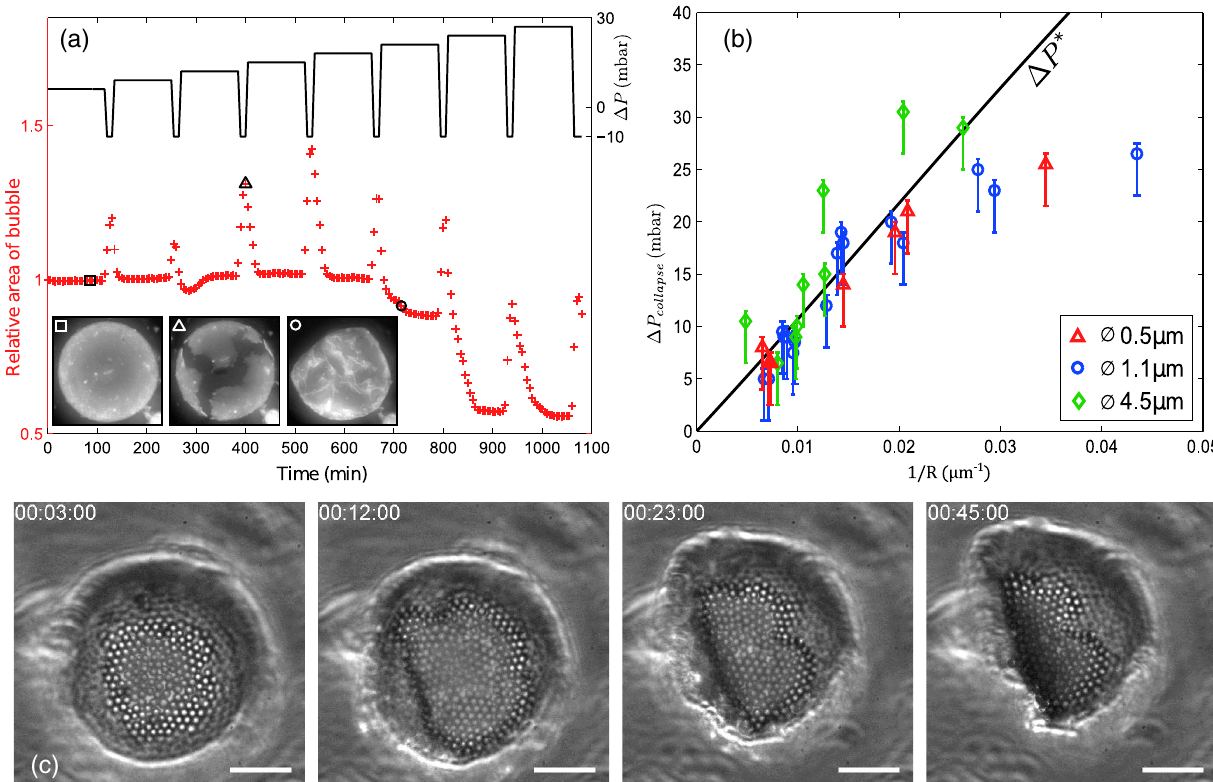
FIG. 3. (a) Typical evolution of the bubble projected area (plus) with the imposed overpressure Δ P (minus) over time. The insets are fluorescence micrographs from the corresponding experiment. The figure shows the blocked armor (square, R ¼ 100 μ m), the appearance of fractures during the bubble swelling step (triangle), and finally the buckled armor (circle). (b) Plot of Δ P function of 1 =R , for three particle diameters. The error bars are estimated from the uncertainty in the measurement of P the Δ P steps. The black line shows the value of collapse pressure predicted by our model Δ P (cid:3) ≈ 1 . 57 γ =R . (c) Detail of the buckling event for a bubble armored with 4 . 5 μ m beads dissolving at Δ P ¼ 50 mbar. Scale bars are 30 μ